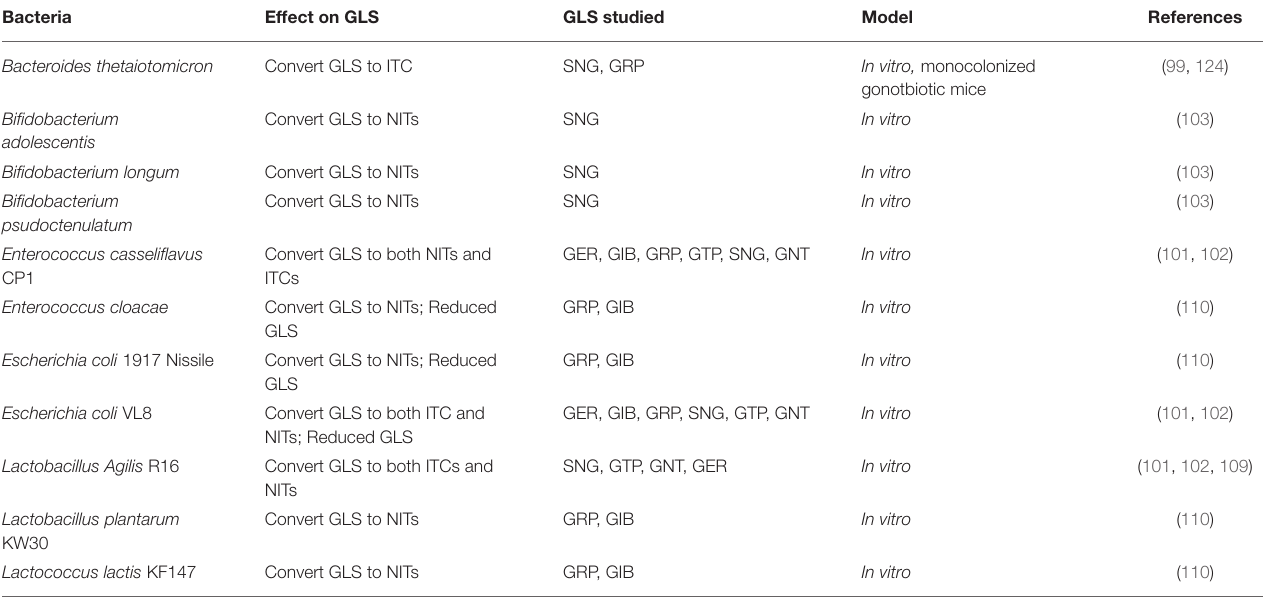
TABLE 1 | Bacteria shown to metabolize glucosinolates